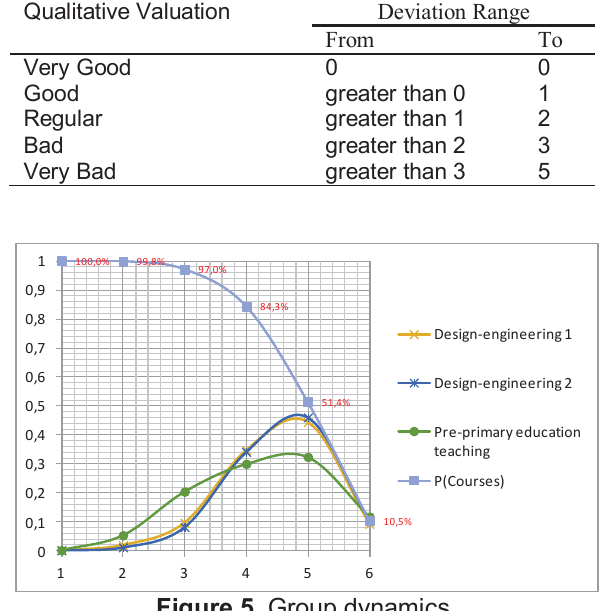
Figure 5 . Group dynamics